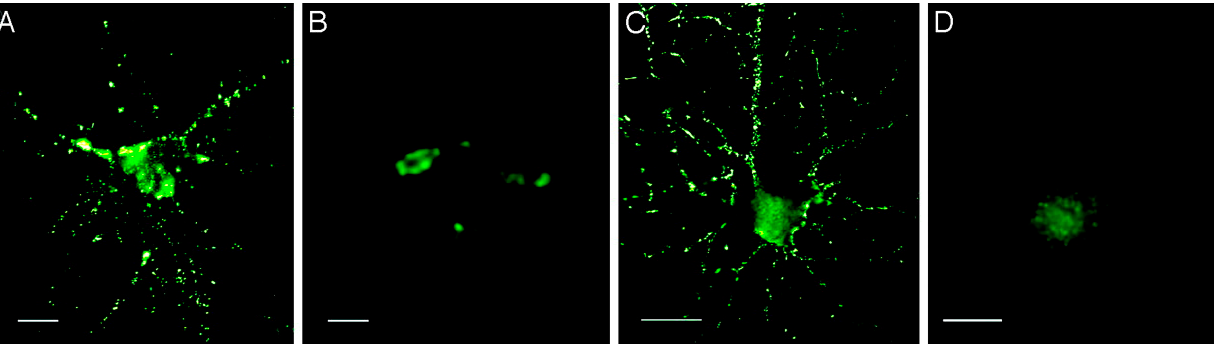
Figure 2. A β -derived diffusible ligands (ADDLs) from the AD brain or prepared in vitro show identical punctate binding to neuronal cell-surface proteins. Cultured hippocampal neurons were incubated with soluble extracts of the human brain or synthetic ADDLs. Binding was visualised by immunofluorescence microscopy by using an M93 antibody. Soluble AD-brain proteins ( A ), soluble control-brain proteins ( B ), synthetic ADDLs ( C ), and synthetic ADDLs ( D ) pretreated (1 h) with an oligomer-selective antibody M71 are shown. Small puncta, typically <1 μ m, and largely distributed along neurites, are evident for AD extracts and synthetic ADDLs, but not for control extracts or antibody-pretreated ADDLs. (Bar, 10 μ m). The figure is reprinted from [15]. However, these A β preparations are also significantly different in certain ways.